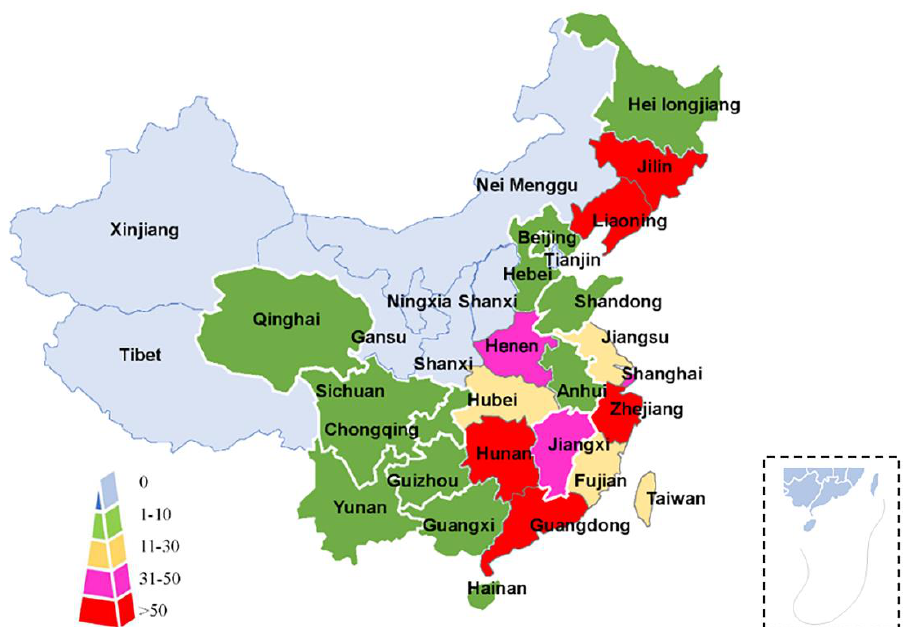
Figure 3. Geographical distribution of human sparganosis in mainland China.